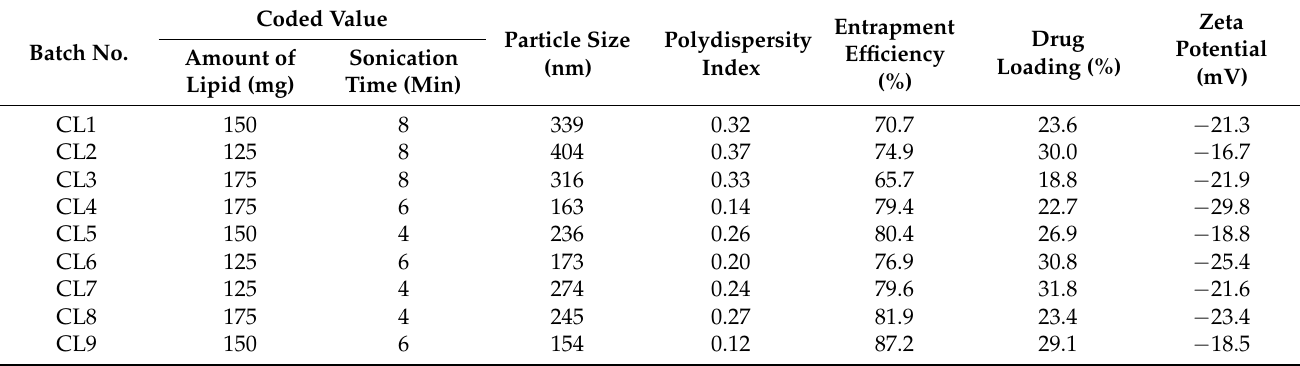
Table 6. Evaluation of 3 2 full factorial design batches.